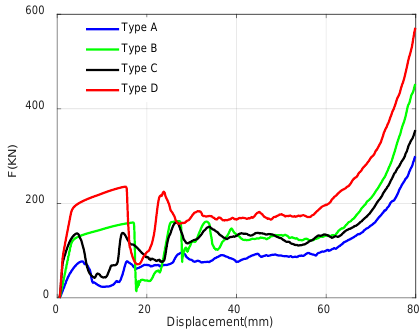
Figure 22. Comparison of four lattices in terms of the quasi-static compressive force and displacement.